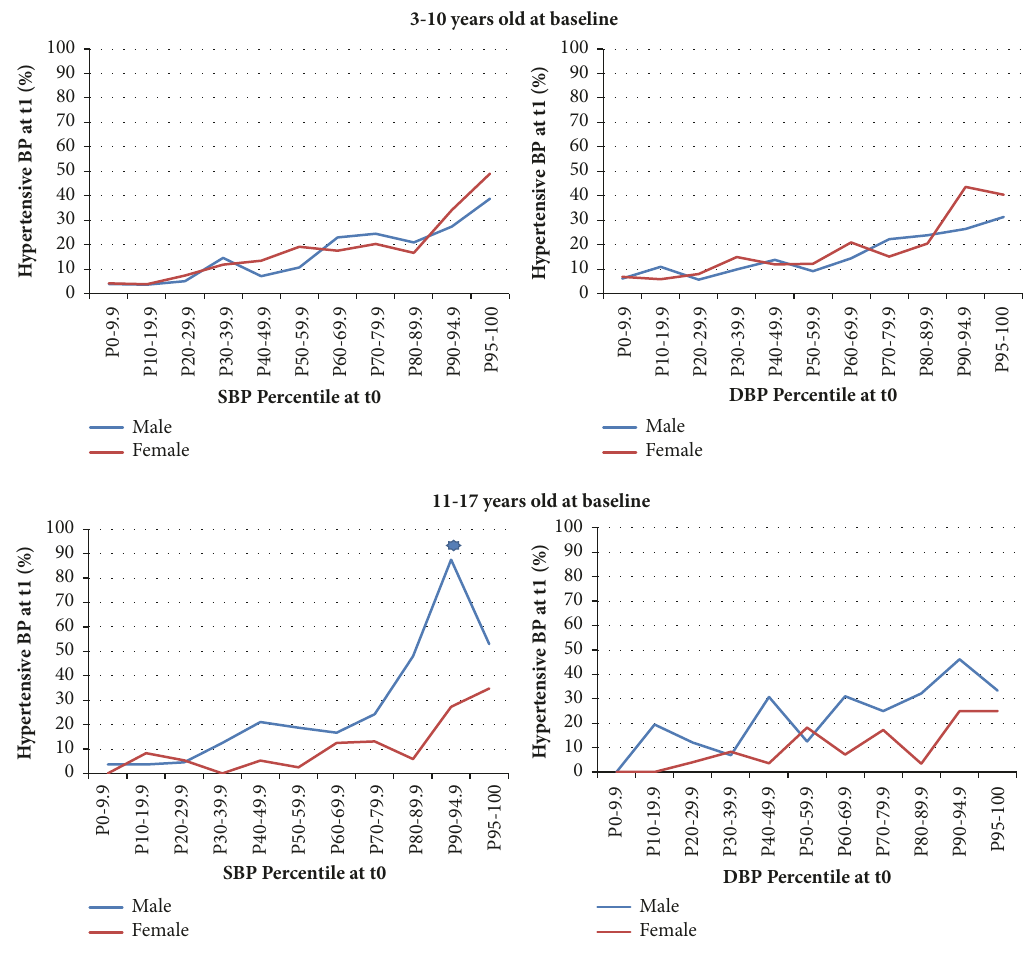
Figure 2: Probability of having hypertensive BP at six year follow-up (t1) according to baseline BP percentiles.